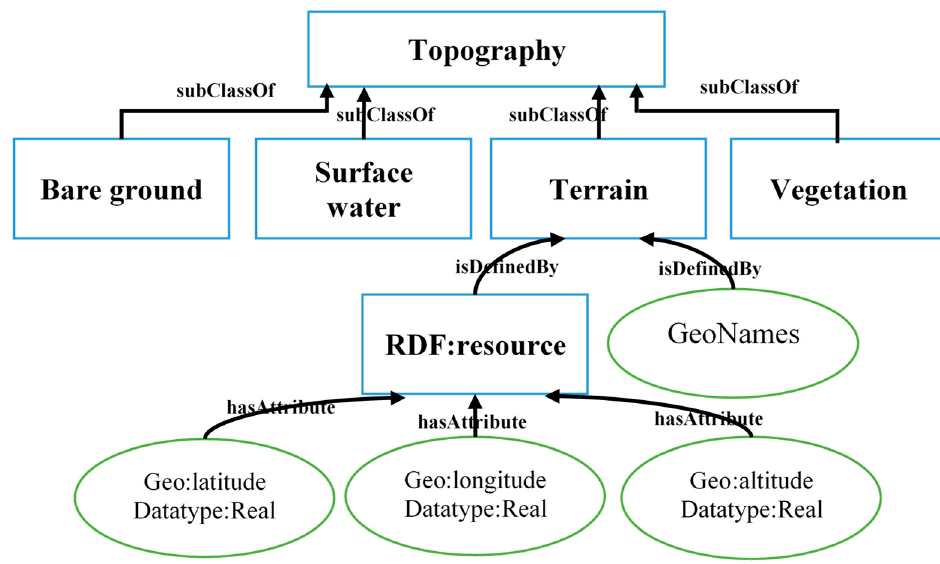
Figure 3. A geographic information science (GIS) entity representation as an RDF.